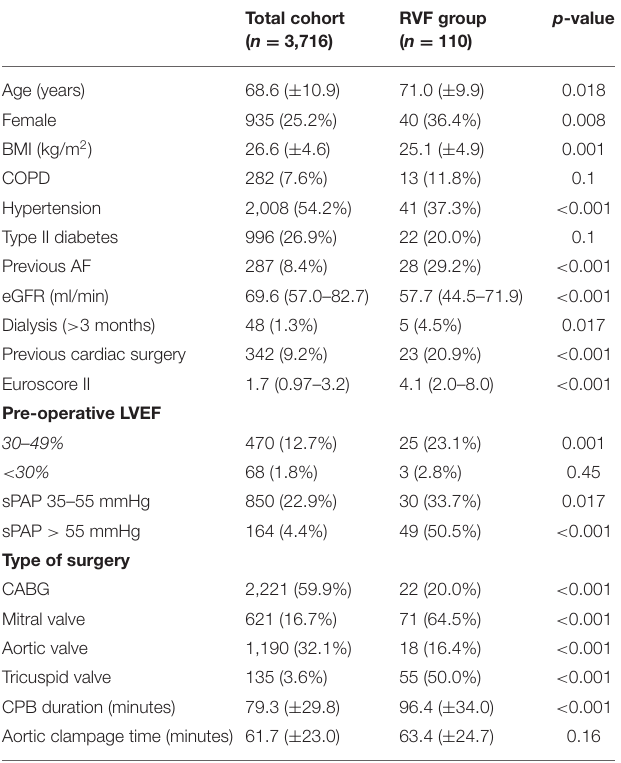
TABLE 1 | Baseline characteristics.